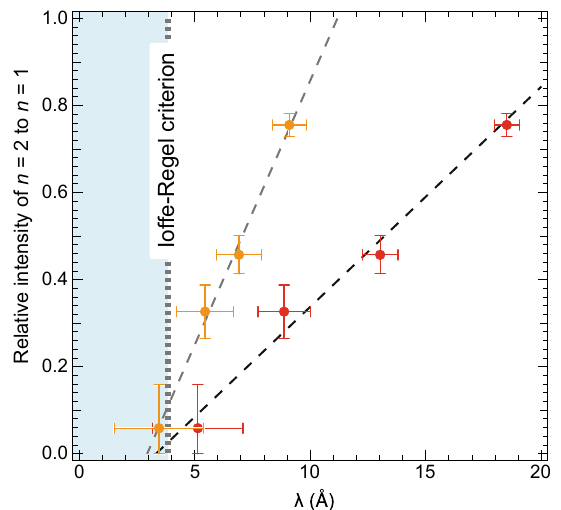
Fig. 3 Relationship between standing-wave formation and λ . The relative intensity (area under the curve) of n = 2 to n = 1 states is plotted as a function of λ n = 1 (red- fi lled circles) and λ n = 2 (orange- fi lled circles). The values of λ are estimated from the respective MDCs at E F . The Ioffe – Regel criterion ( λ IF min = a ) for STVO is indicated by a dotted line. The results of a line fi t for the data are shown by dashed lines. The plot indicates a proportional relationship between the QW intensity and λ , and the disappearance of QW intensity around λ IF min . The error bars re fl ect the uncertainties in the curve fi